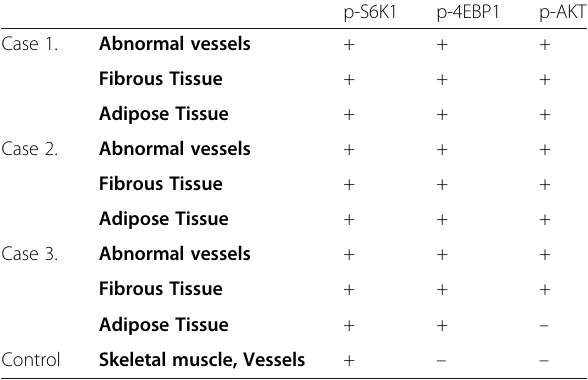
Table 1 Immunohistochemical expression of PI3K/AKT/mTOR pathway in various components